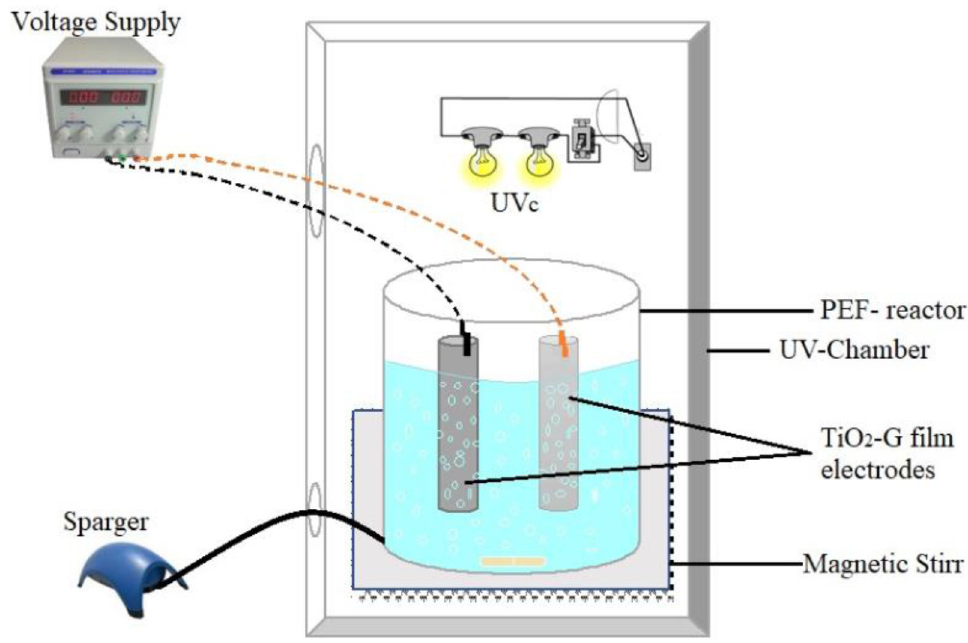
Figure 8. Experimental setup.